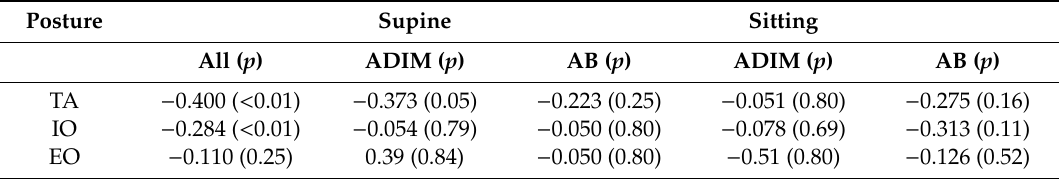
Table 5. Correlation coe ffi cient between muscle thickness and subjective di ffi